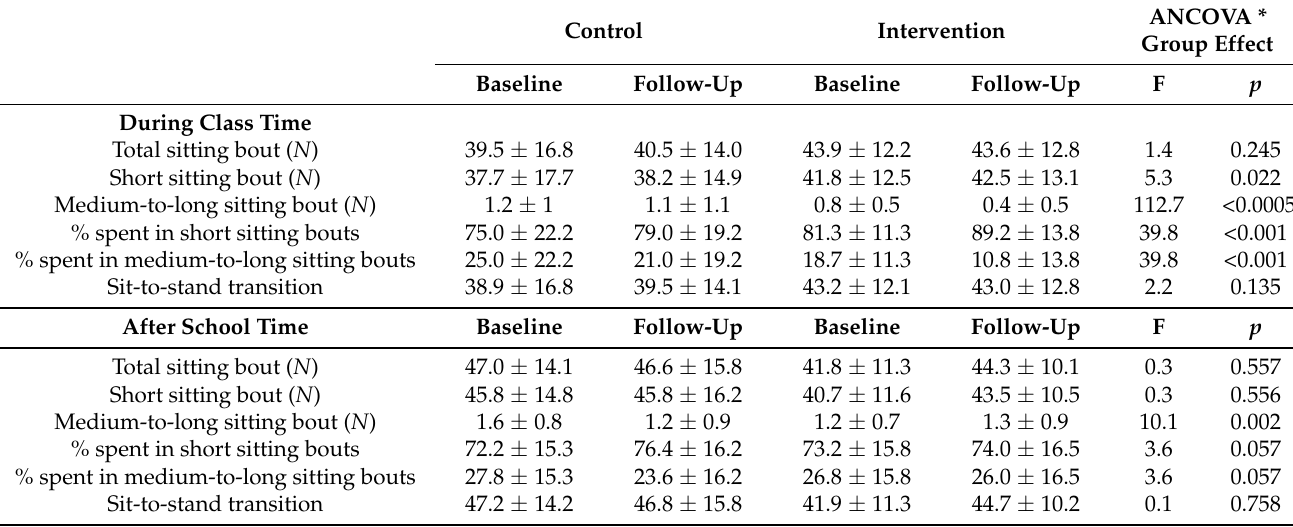
Table 4. Data on sitting bouts derived by the activPAL and the effect of the treatment